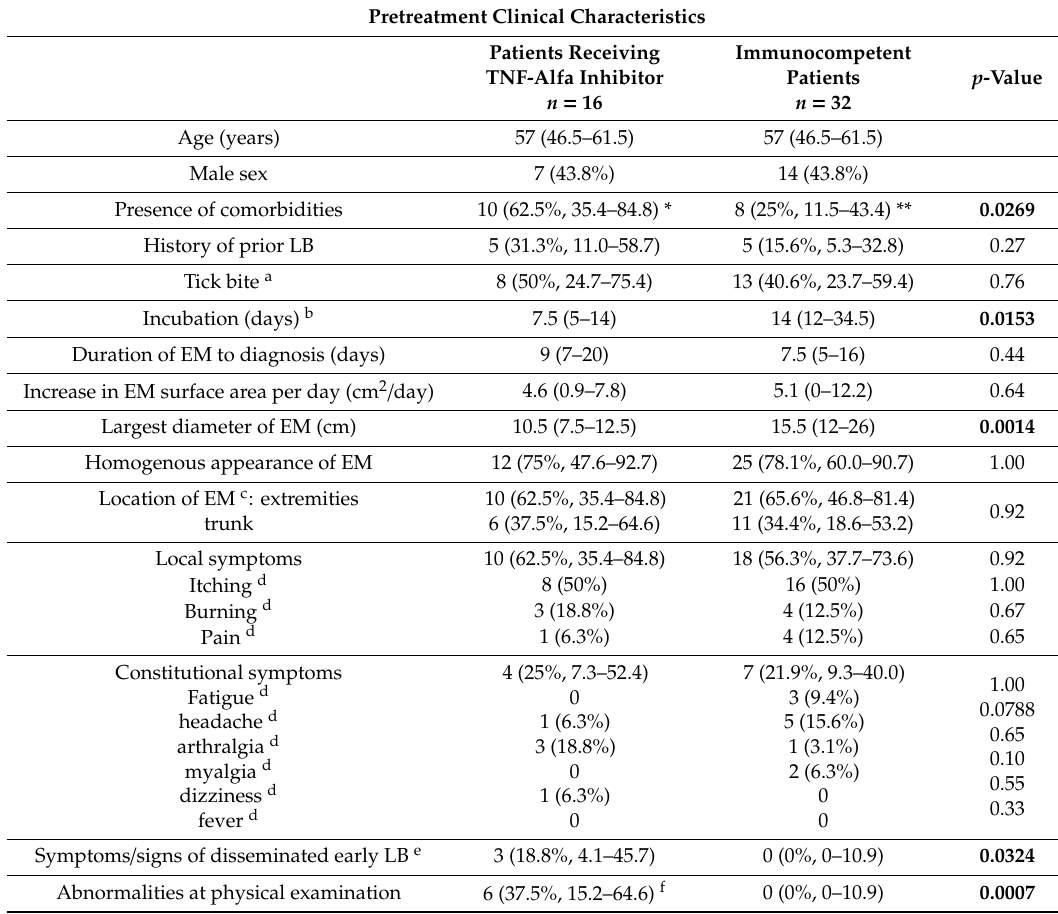
Table 2. Comparison of demographic, clinical, laboratory and microbiological data of 16 patients with erythema migrans who were receiving tumour necrosis factor-alpha (TNF- α ) inhibitors for their underlying disease, and 32 immunocompetent patients with erythema migrans at the initial visit. Pretreatment Clinical